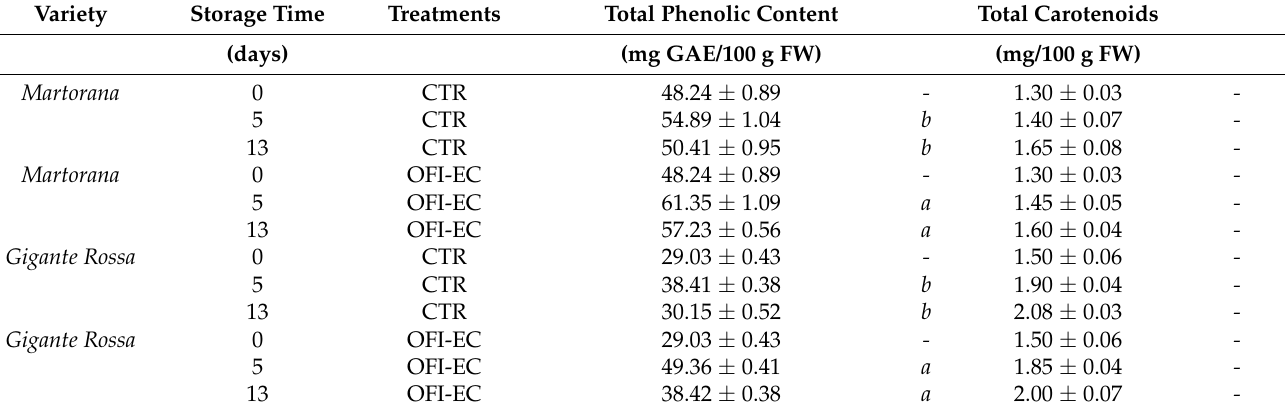
Table 2. Total phenolic and total carotenoids content in minimally processed loquat fruits (cv Martorana and cv Gigante Rossa ), untreated fruit (CTR), and fruits treated with mucilage (OFI-EC) during cold storage (13 days at 5 ◦ C). Different lowercase letters indicate significant differences at p ≤ 0.05 between the treatments on each sampling date. Data are the mean ± SE ( n = 5